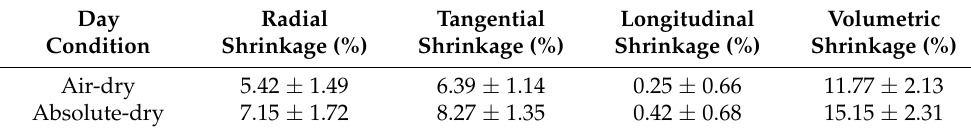
Table 4. The mean values of shrinkage of the culm wall in different drying conditions. Day Condition